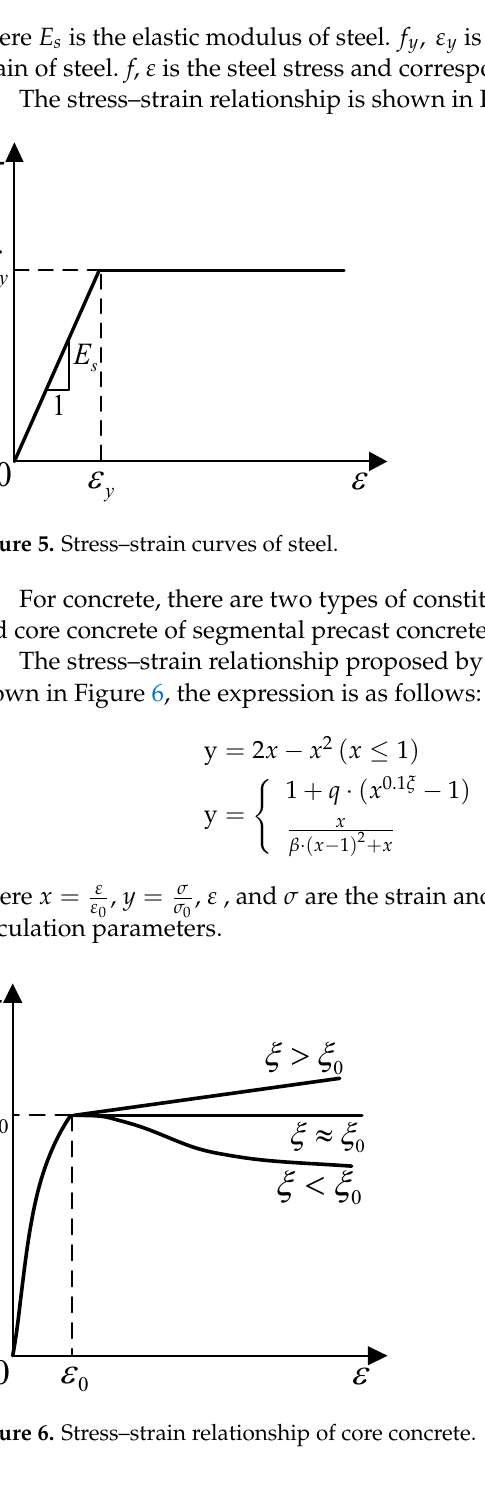
0 Figure 6. Stress–strain relationship of core concrete. The CDP damage plasticity model [23,24] is for the damage of external concrete in the process of stressing, and its tensile stress–strain expression is as follows: